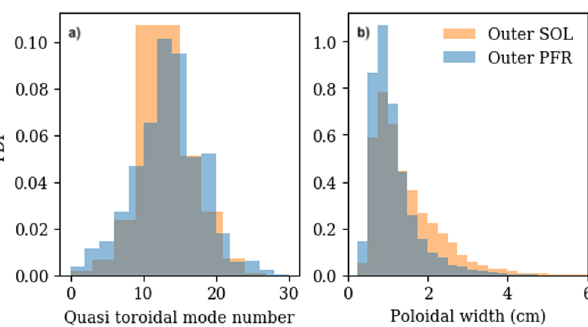
Fig. 3 Spatial distribution and width of turbulent structures in the outer divertor leg. a Quasi-toroidal mode number and ( b ) poloidal Full-Width Half-Maximum (FWHM) cumulative distributions of turbulent structures across all discharges detailed in table 1 for the private fl ux region (PFR) at ψ N = 0.99 (blue) and scrape-off layer (SOL) at ψ N = 1.01 (orange) of the outer divertor leg where ψ N is the normalised poloidal fl ux coordinate.